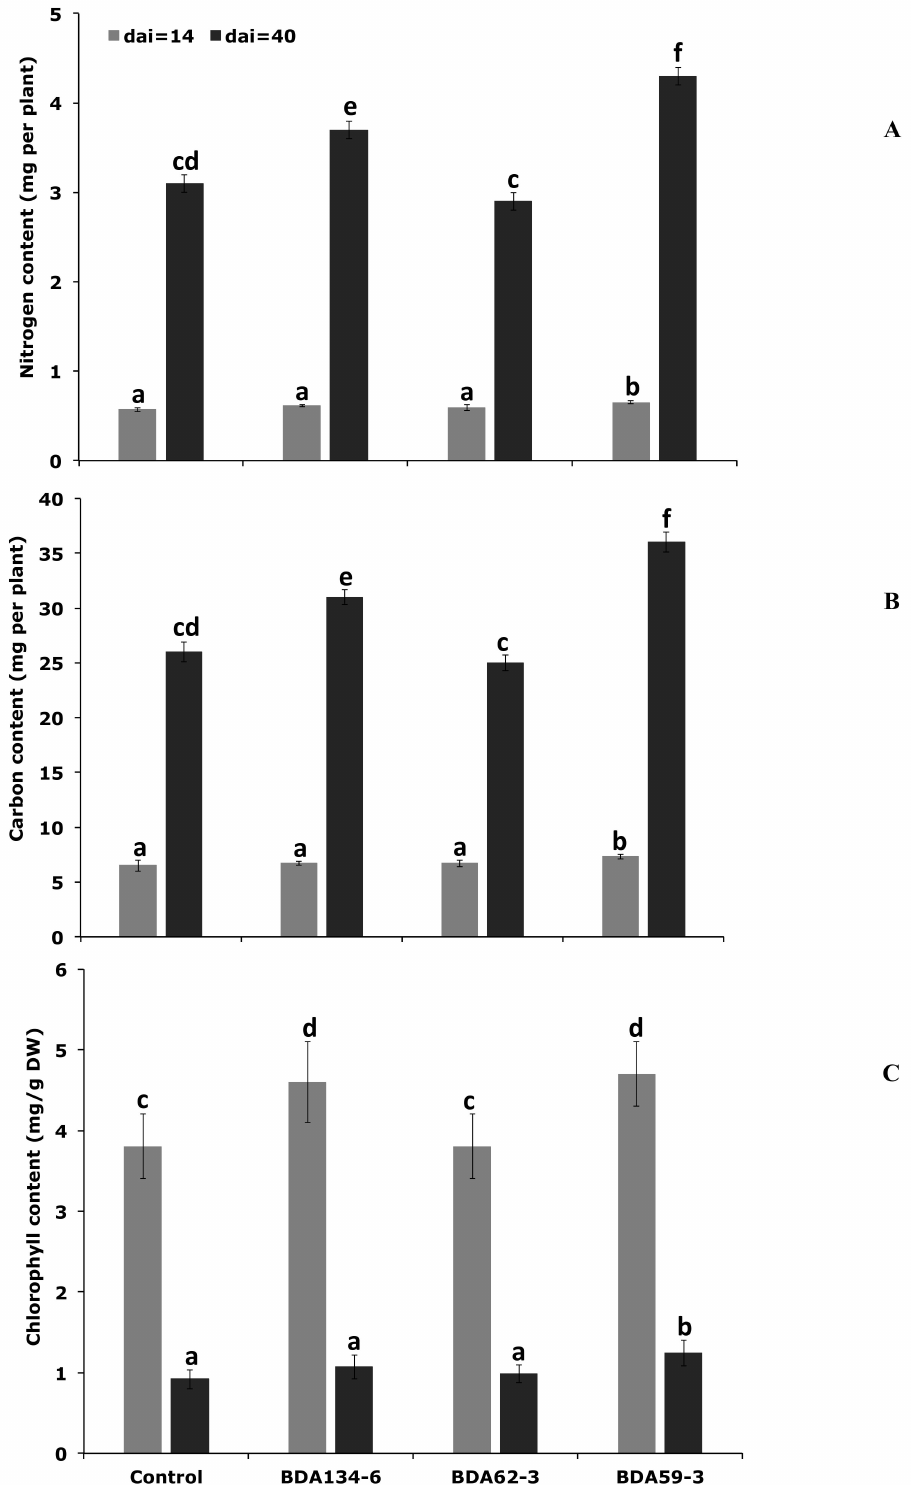
Figure 5. Effect of inoculation with Ko. pseudosacchari BDA62-3, Kl. pasteurii BDA134-6 and P. diazotrophicus BDA59-3 on physiological parameters of O. sativa L. cv. Baldo plants. O. sativa plants were inoculated with the individual strains and grown in hydroponic conditions as described in Material and Methods section. At 14 and 40 DAI, plants were removed from the growth unit and the leaves detached and used for the analyses of N ( A ), C ( B ), and chlorophyll ( C ) content. Data are the means ± SD of at least five independent biological replicates each carried out at different times. Means with different letters are significantly different at 5% level of confidence (Tukey’s post hoc